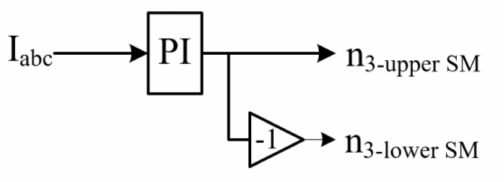
Figure 7. Zero-sequence current eliminating control.